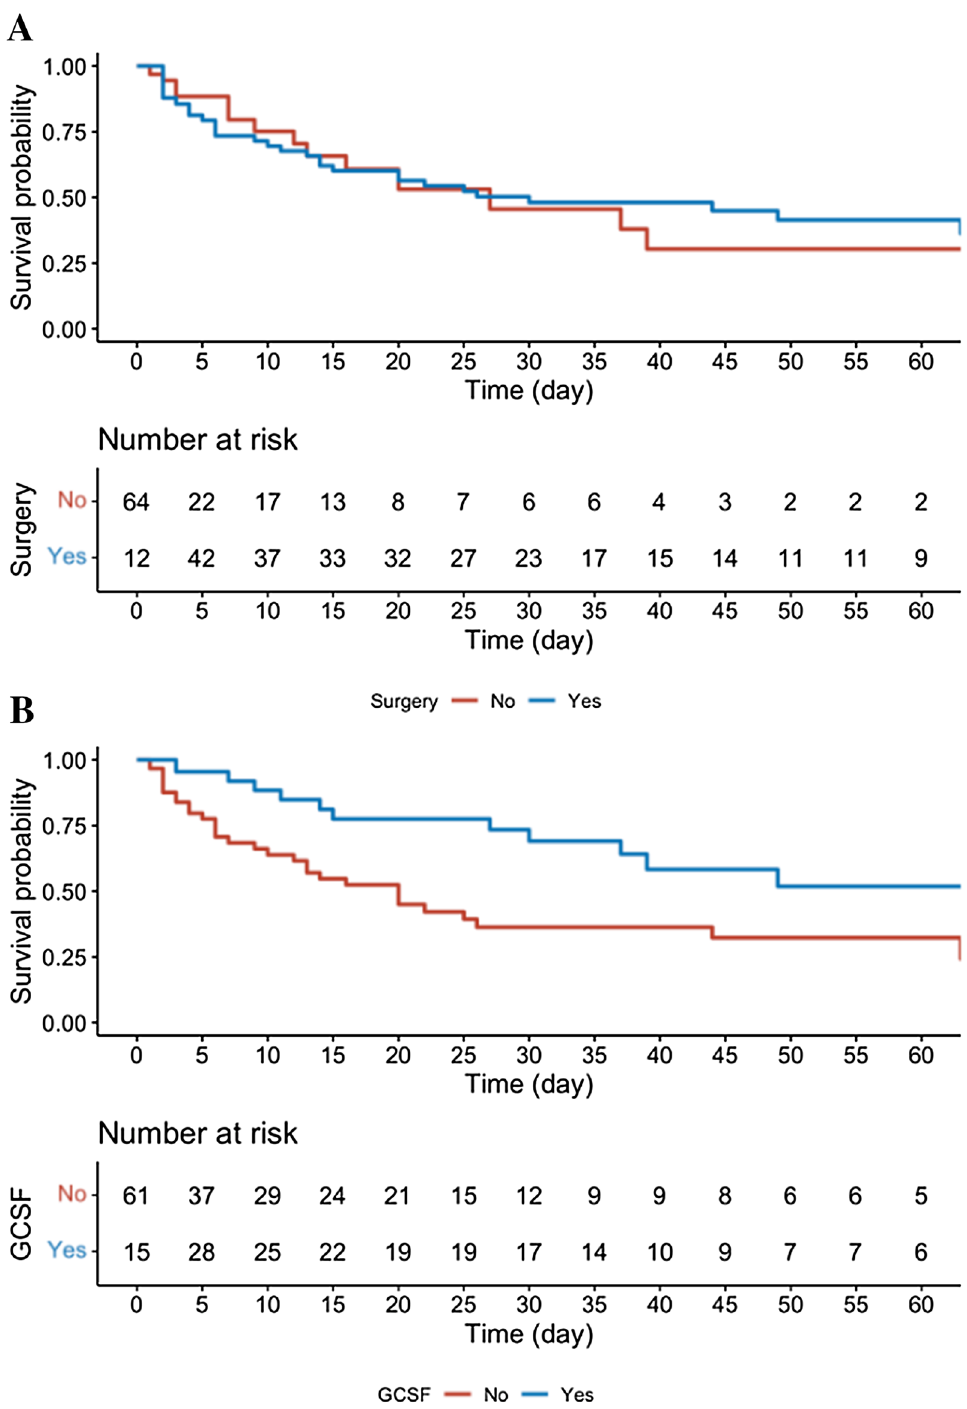
Fig. 1 Univariable Kaplan–Meier curves of the probability of survival according to surgery ( A ) and granulocyte colony‑stimulating factor (G‑CSF) treatment ( B ). Blue lines indicate patients who received the treatments (surgery in panel A , G‑CSF in B ); red lines indicate patients who did not receive the treatments (no surgery in A , no G‑CSF in B